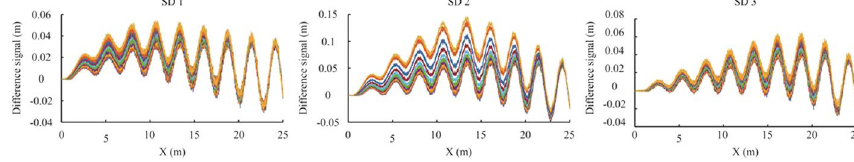
Fig. 10 The difference in the displacement signal of intact and damaged structure in the noise-free mode for 3 single-damage scenarios